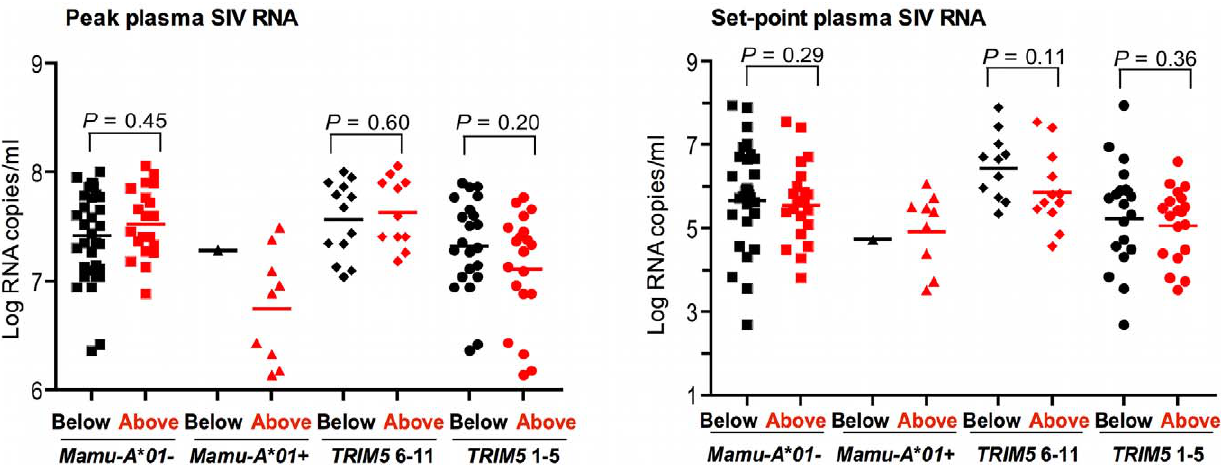
Figure 4. Lack of association of CCL3L CNV with virus replication in Indian-origin rhesus monkeys following SIVmac251 infection. The plasma SIV RNA levels were assessed on days 14 and 70 following challenge, representing peak and set-point plasma SIV RNA levels, respectively. The monkeys were divided into 2 groups, one having CCL3L copy numbers below the median in this cohort of monkeys (black), and the other having CCL3L copy numbers above the median (red). These two groups of rhesus monkeys were subdivided into four separate groups according to their expression of Mamu-A*01 ( 2 or + ) and TRIM5 alleles (6–11 or 1–5). The association of CCL3L groups with plasma SIV RNA levels was assessed. The comparisons were analyzed using the Mann-Whitney U test (two-tailed).